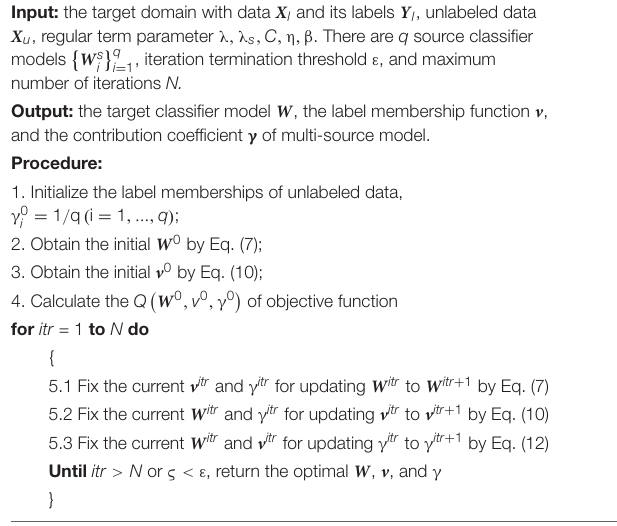
TABLE 1 | Algorithm description of